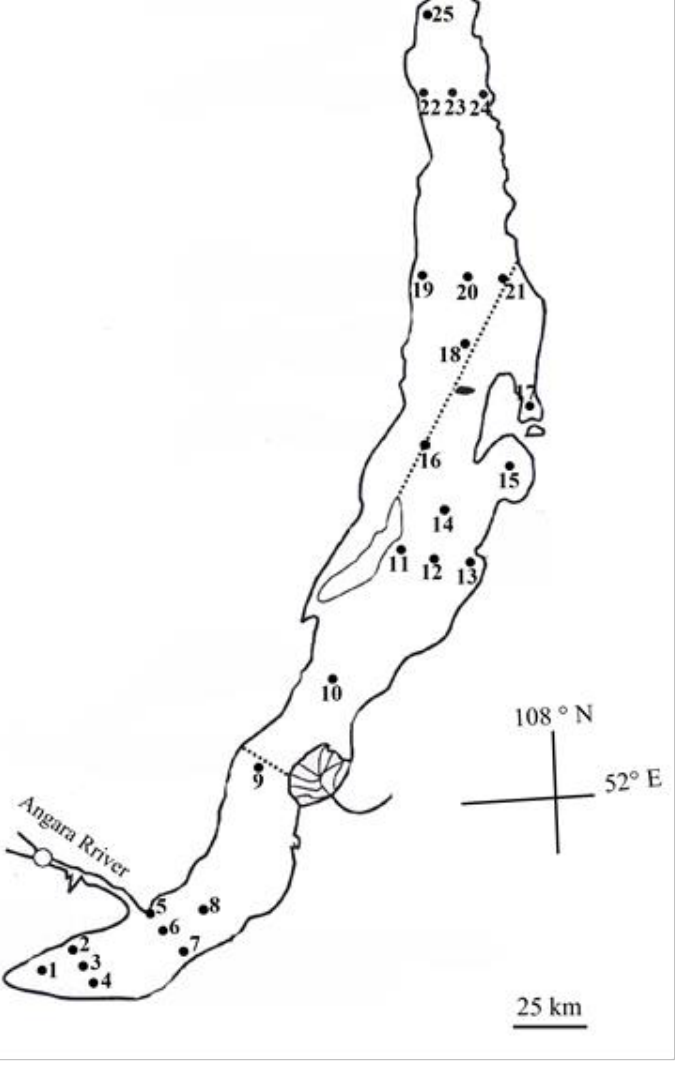
Fig. 1. Sampling scheme. A dashed line shows borders of the lake: Southern, Central and Northern Baikal Study